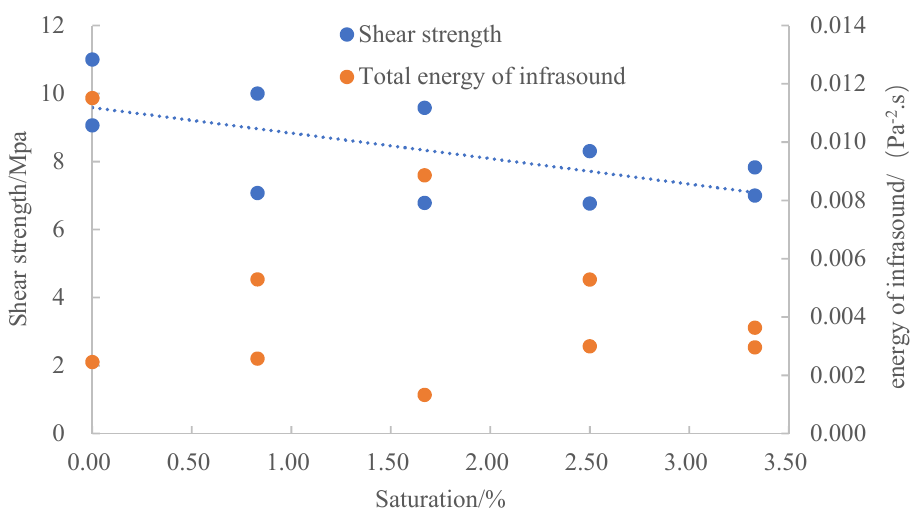
Figure 10. Relationship of shear resistance strength and infrasound energy with water saturation. From the perspective of acoustics, with increased water saturation, the total energy (Figure 10) and the number of infrasound events (Figure 11) generated during the rock shear failure show little regularity. Since the rock samples in this study were tight sandstone ones and did not change much in water saturation before and after soaking, the total energy and number of infrasound events showed little regularity in variation. However, the average excellent frequency of infrasound events decreased linearly in general with increased water saturation. Affected by water saturation, the shear resistance strength of the rock decreased, and the shear failure of the rock became easier; therefore, the failure speed increased, the failure surface became flatter and flatter, and the corresponding excellent frequency of infrasound became smaller and smaller.